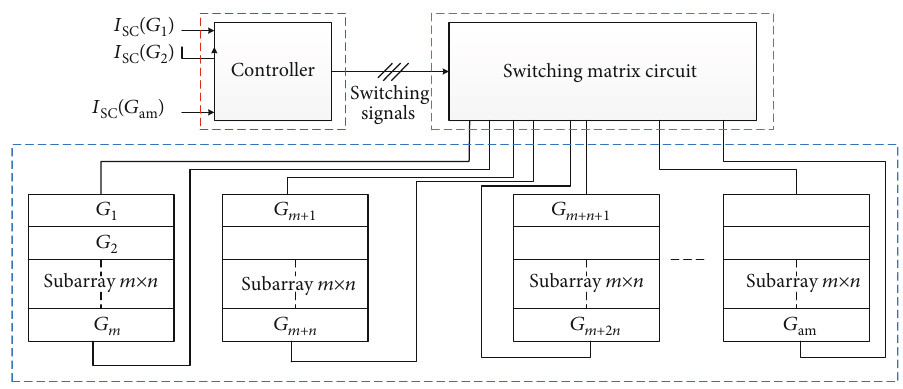
Figure 4: Connection architecture of the proposed two-step recon fi guration method.